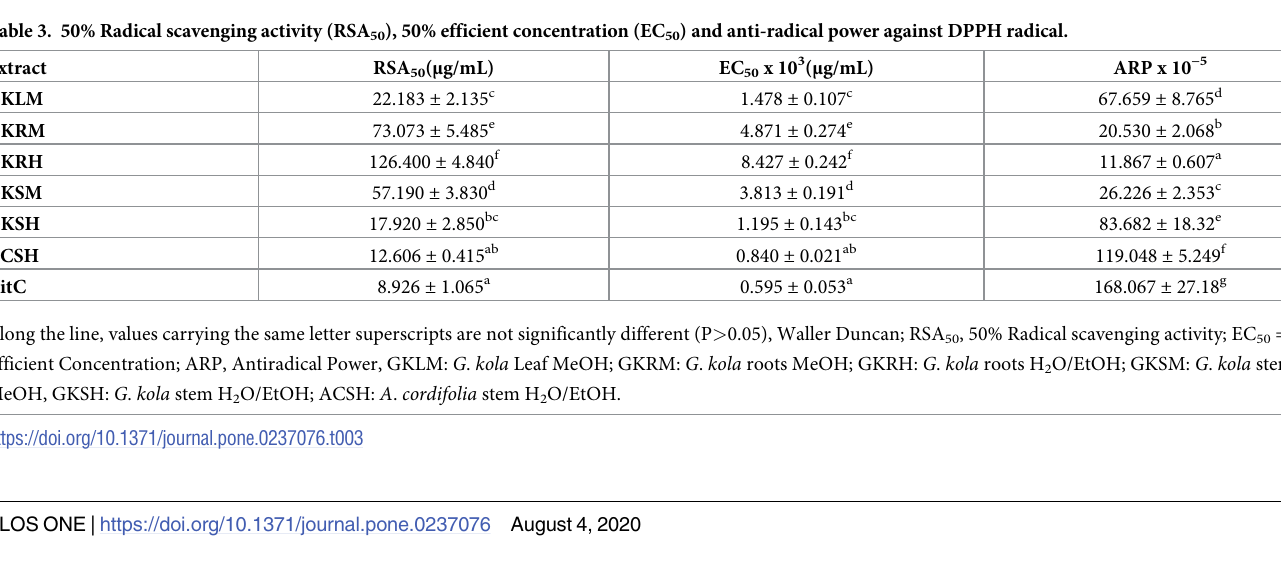
Table 3. 50% Radical scavenging activity (RSA 50 ), 50% efficient concentration (EC 50 ) and anti-radical power against DPPH radical. Extract